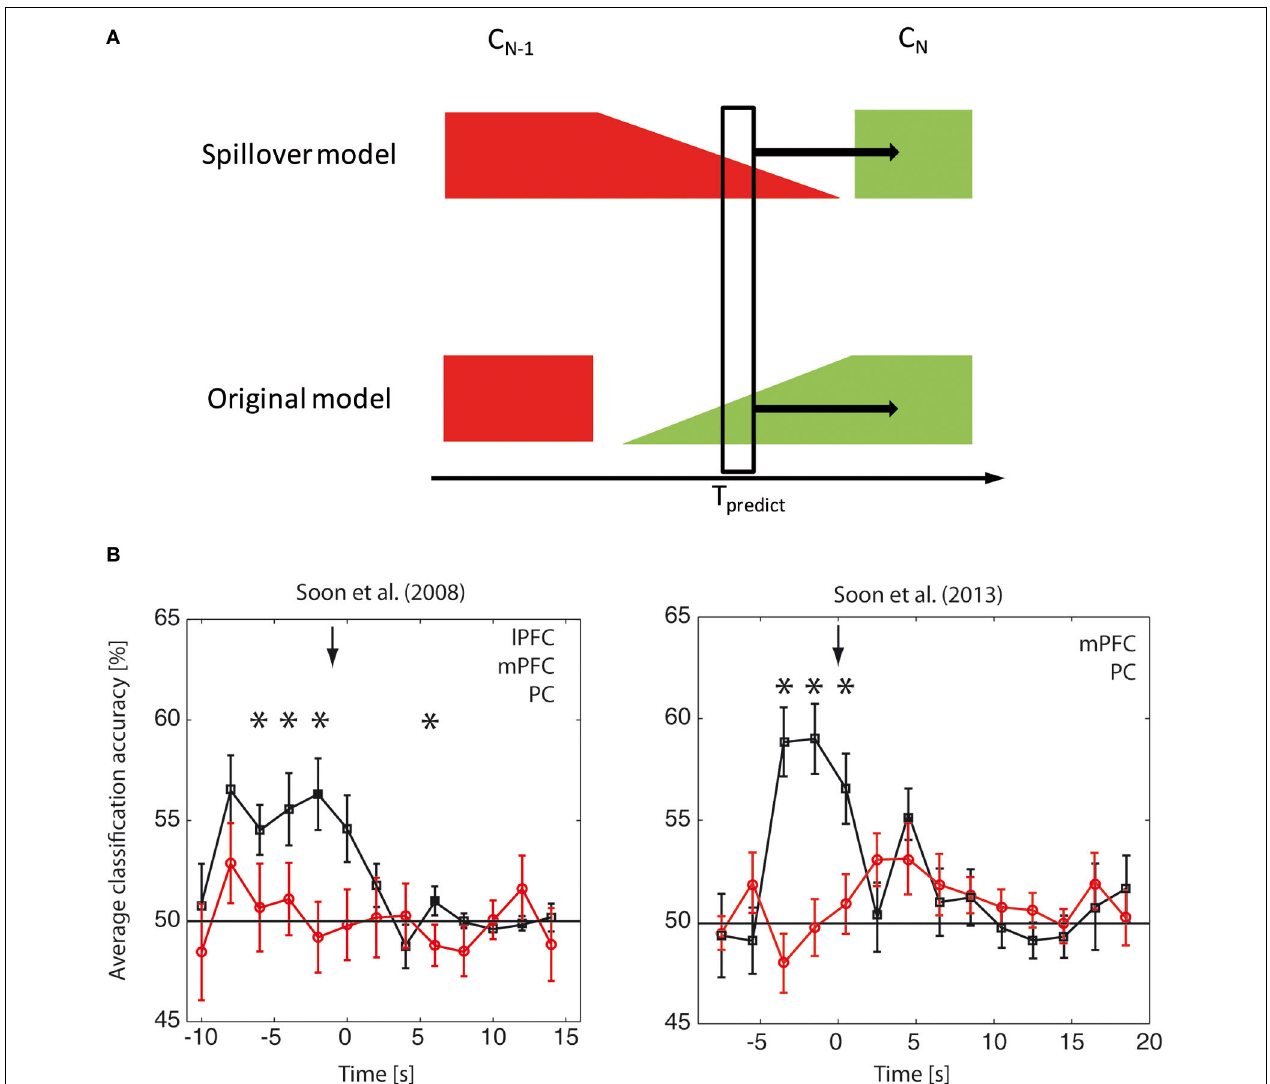
FIGURE 1 | Choice-predictive brain signals and previous trials. (A) The spillover model assumes that the predictive classification of choice C N at time T predict is based on some form of residual information lingering from the previous choice C N − 1 (red). The original model assumes that the predictive classification reflects the emergence of choice-related processes (green) that does not directly reflect an explicit representation of the previous trial, even though it presumably evolves in some way from the previous trial based on the causal dynamics of the brain. In the spillover model the prediction of C N is based alone on signals related to C N − 1 and is due to the fact that the two choices C N − 1 and C N are correlated. Please note that if this were the case then the signal recorded at T predict should contain substantially more information about C N − 1 than about C N . So if the spillover model is true, it should be possible to decode the previous trial C N − 1 considerably better than the current trial C N . In contrast, if the original model is true, then a shift in labels by trial would largely abolish all predictive signals. (B) Reanalysis of choice-predictive brain signals with labels shifted by one trial. For this reanalysis of the original data (left: Soon et al., 2008; right: Soon et al., 2013) we shifted the trial labels by one trial, thus investigating whether a shifted model reflecting a spillover from the previous